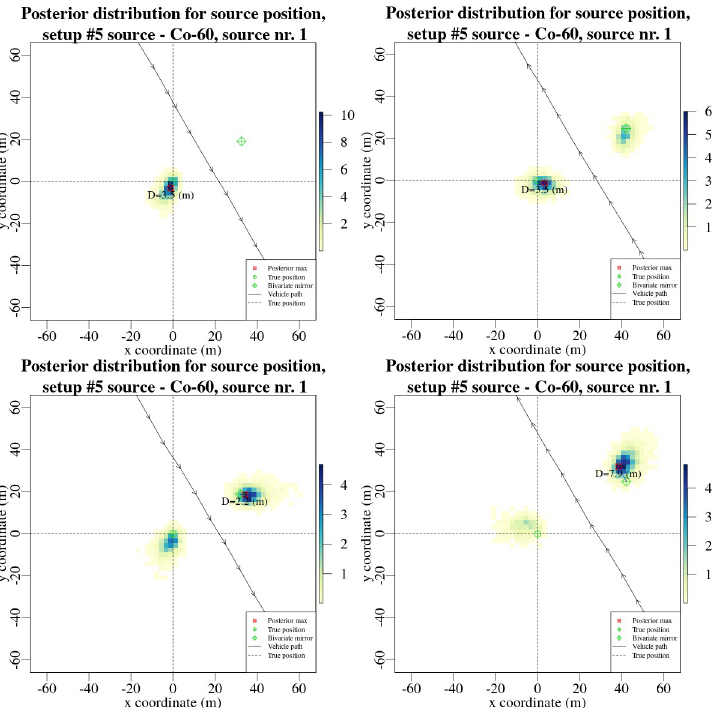
Fig 13. Posterior probability distributions for source position for experimental setup 5, 60 Co source, obtained from data collected using only HPGe detector while passing the source in both directions. The colour within the posterior distributions denotes the relative probability of the source being there—the darker the colour the higher the probability. The crossed dashed lines marks the actual position (True position, as marked in the legend) of the radiation source. The arrows marks the geographical coordinates recorded using GNSS system each